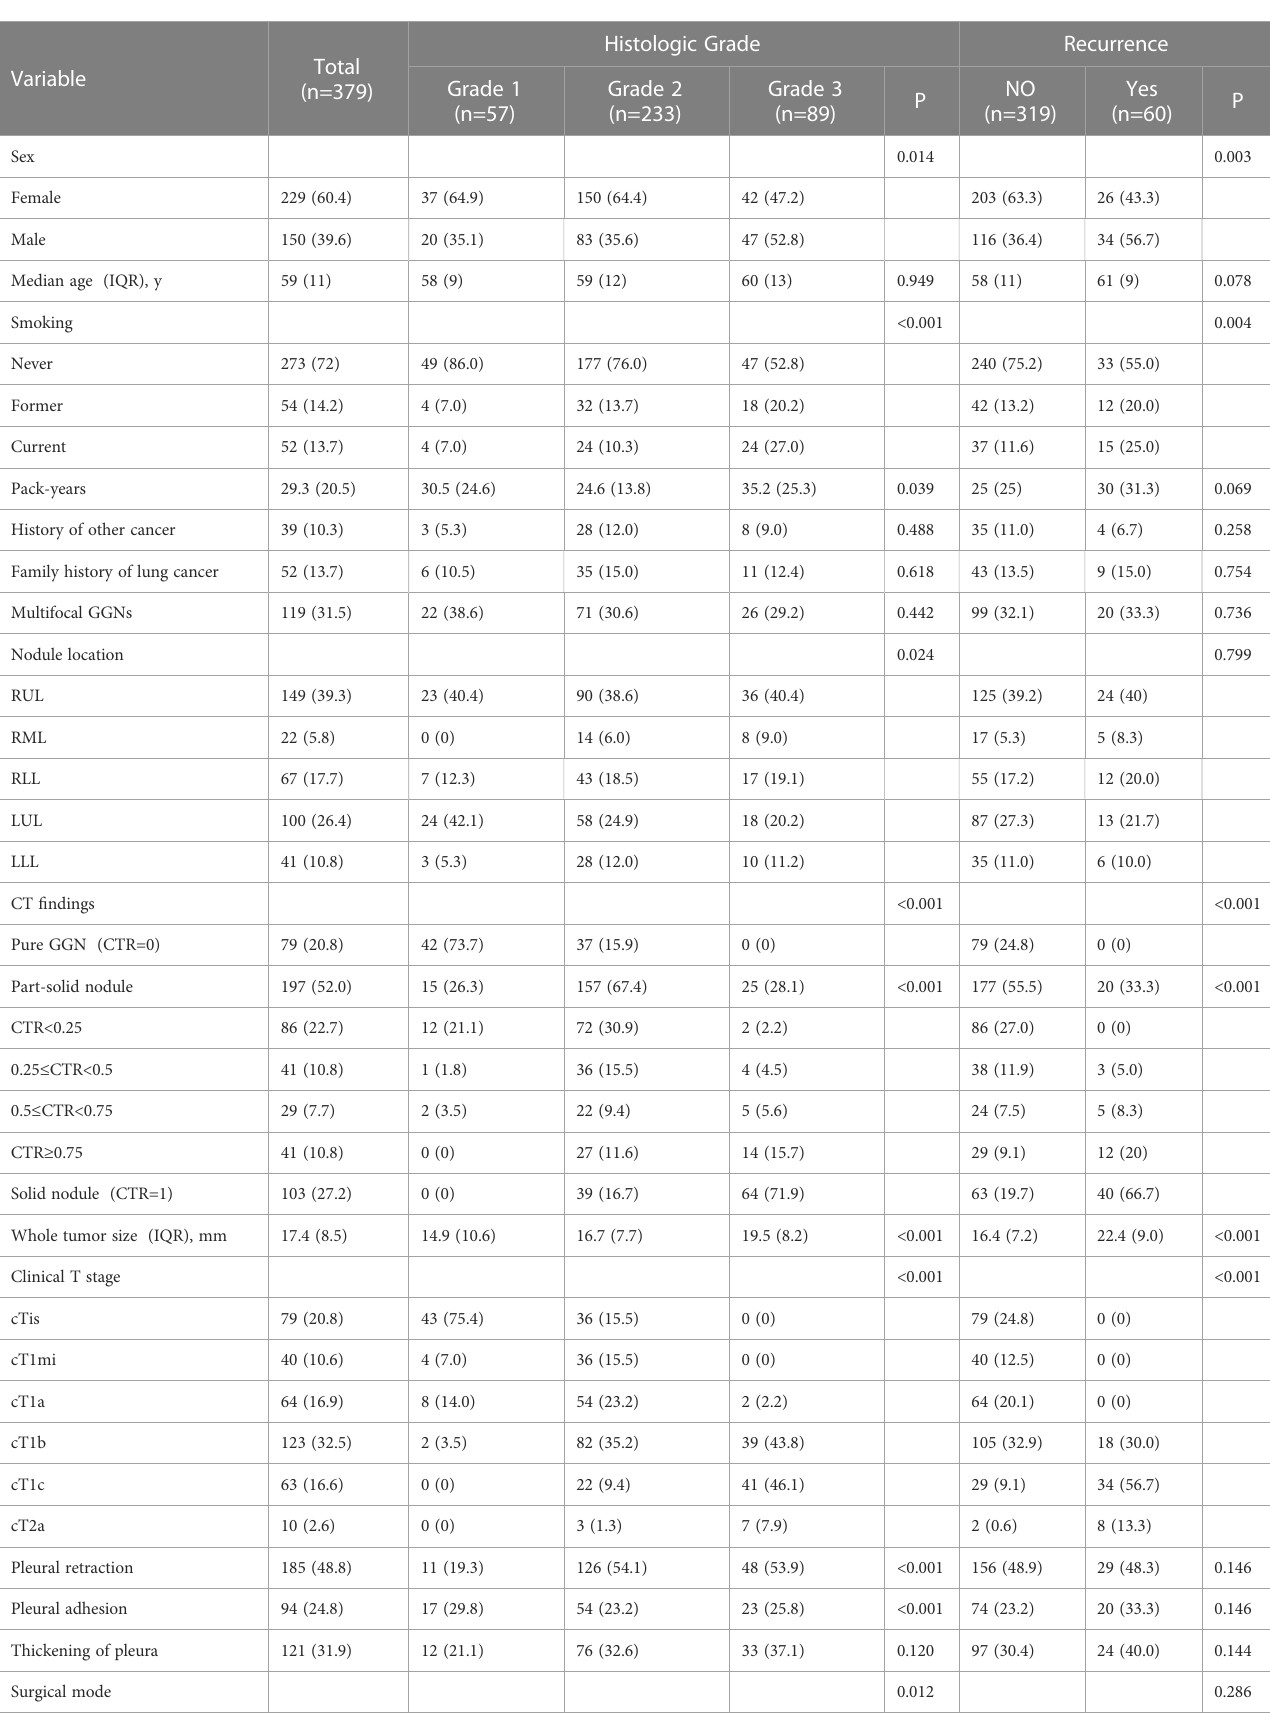
TABLE 1 Patients ’ and nodules ’ characteristics based on histologic grades and outcomes in p-stage I